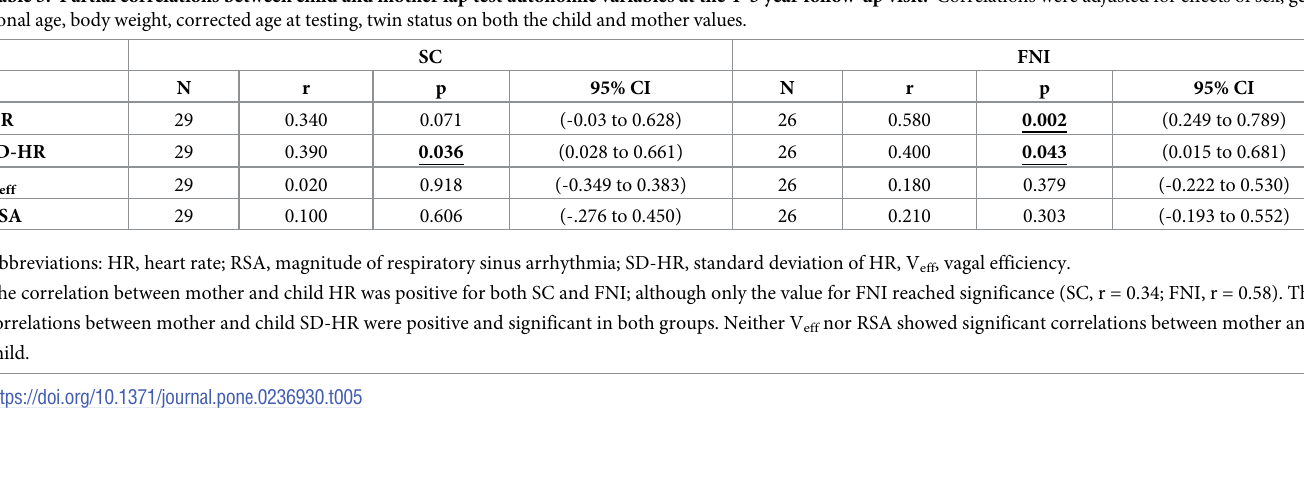
Values for HR and SD-HR are based on averages across multiple 30 sec epochs. Values for V eff are derived from 10-second epochs and reflect the slopes of the relationship between heart period (i.e., mean of the R-to-R intervals) and RSA, one value for each subject. Two sets of data are shown; the top set are values for all measurements made on these mothers. The lower set are values only from when mothers were tested with their singleton child or one twin. These means and SE are after adjustment for covariates (gestational age at birth, birth weight, age in months at the time of assessment (adjusted for weeks premature), sex, and twin status (Y/